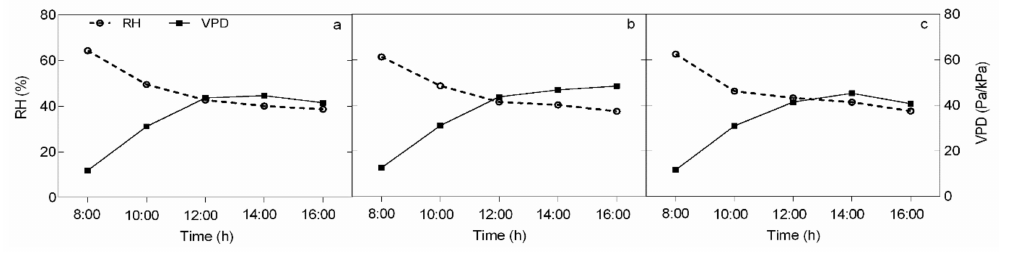
) Relative humidity and ( (cid:4) ) (cid:35)